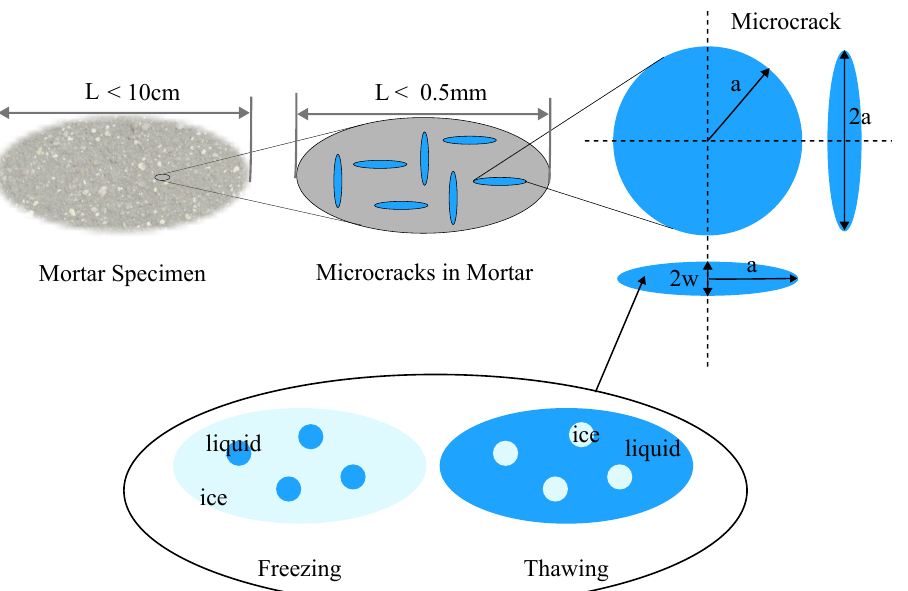
Figure 1. Schematic of the multiscale approach for modeling freezing mortar showing the choice of the representative elementary volumes. Also shown is the ellipsoidal microcrack that is filled with partially saturated liquid-ice mixture (light blue color denotes ice and dark blue color denotes the liquid phase), and the representative elementary volume of partially saturated liquid-ice mixture during freezing and